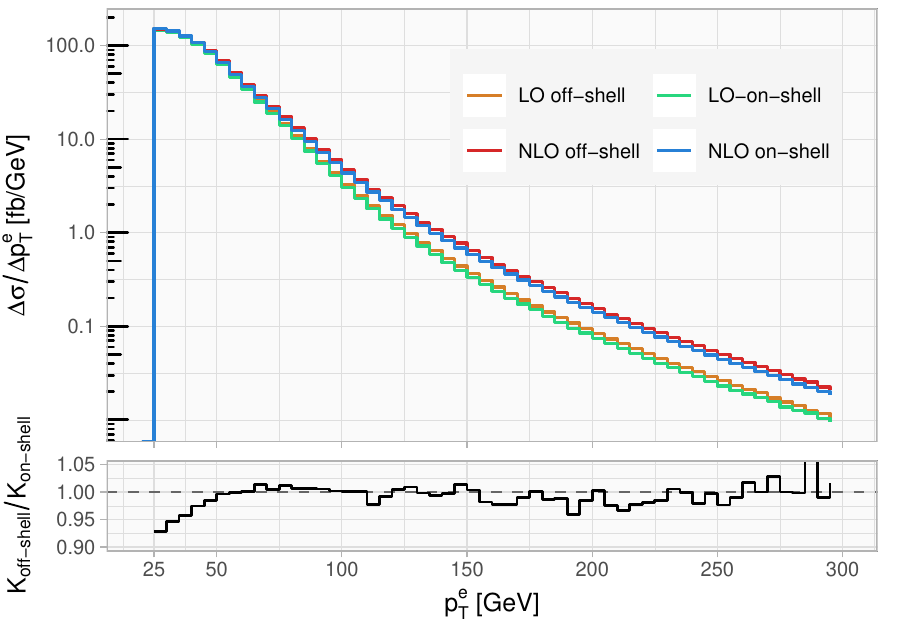
Figure 5. Positron transverse momentum distributions for the top-quark on-shell approximation and for the o(cid:11)-shell top quark at LO and NLO . The lower panel shows the ratio of the NLO / LO K -factors from the o(cid:11)-shell and on-shell